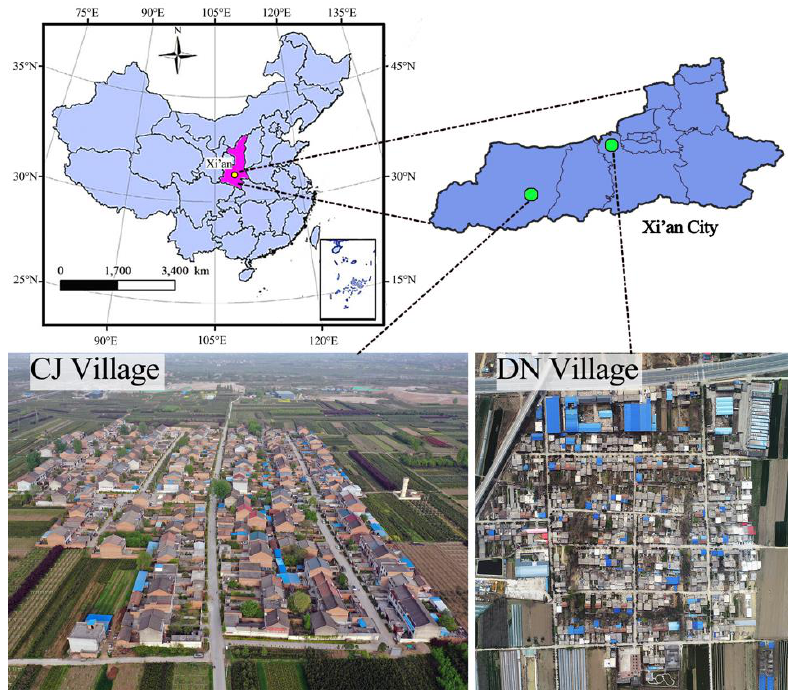
Figure 1. Location of the study site (images of Cai Jia Village and Da Nihe Village were photographed by drone).